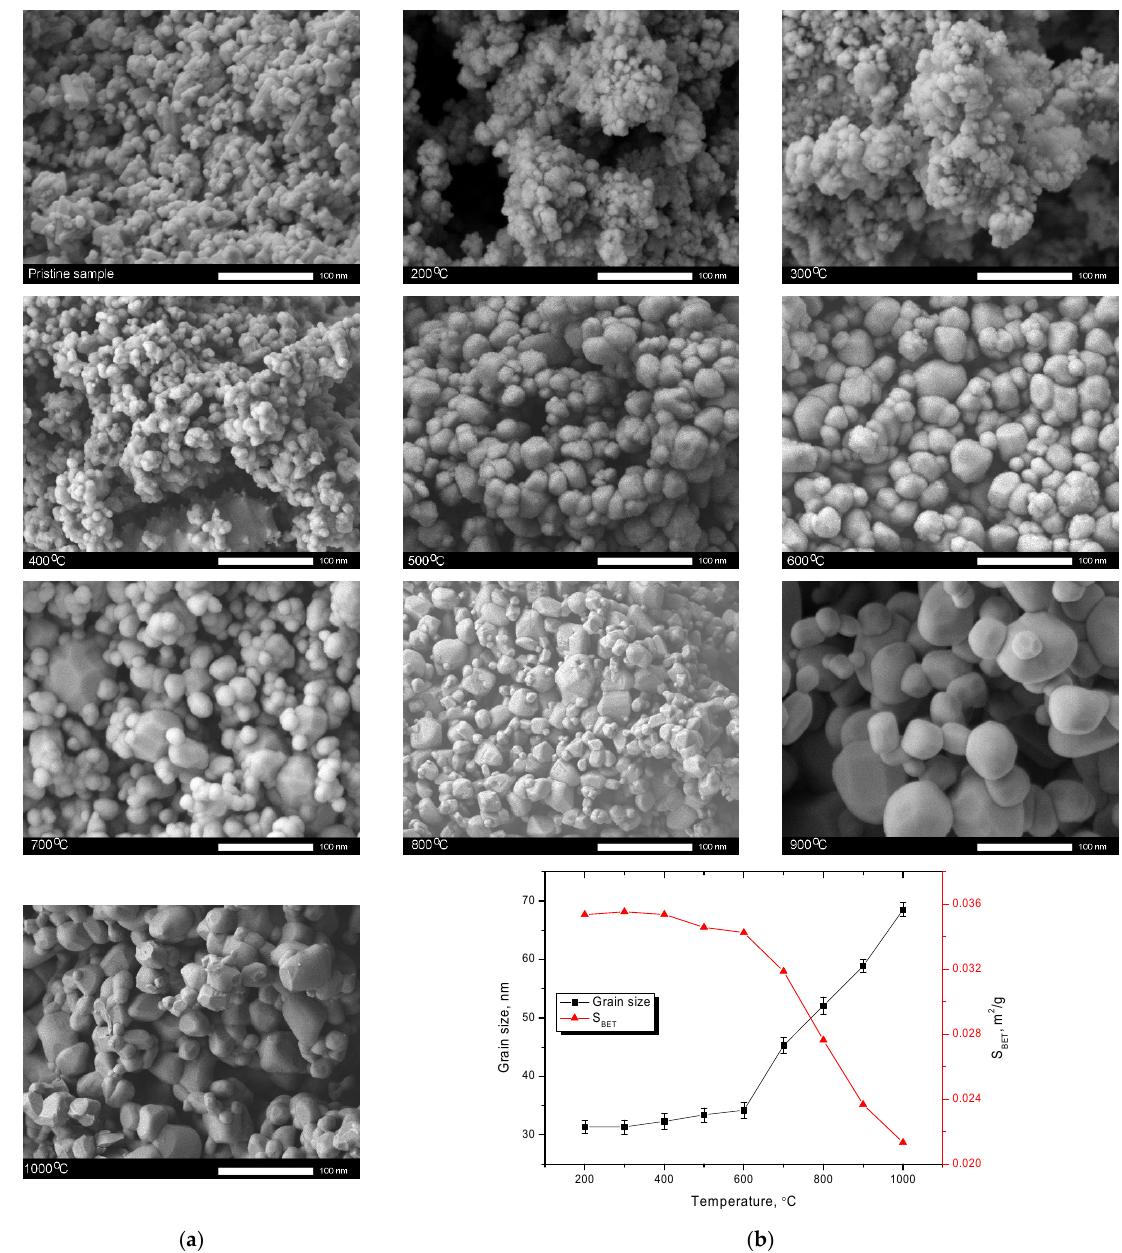
Figure 1. ( a ) SEM images of synthesized NiFe 2 O 4 nanoparticles; ( b ) results of changes in grain size and specific surface area of NiFe 2 O 4 nanoparticles.